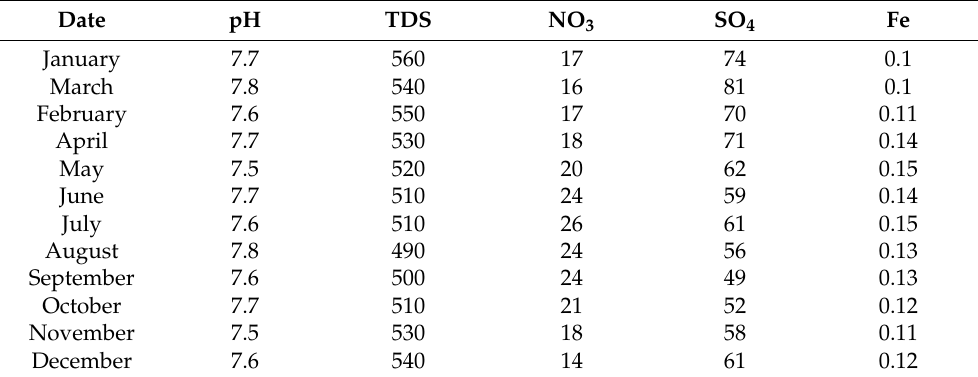
Table 2. Quality of pumped groundwater per year in 2018 (concentrations in mg/L, average of one sample from three wells per month).